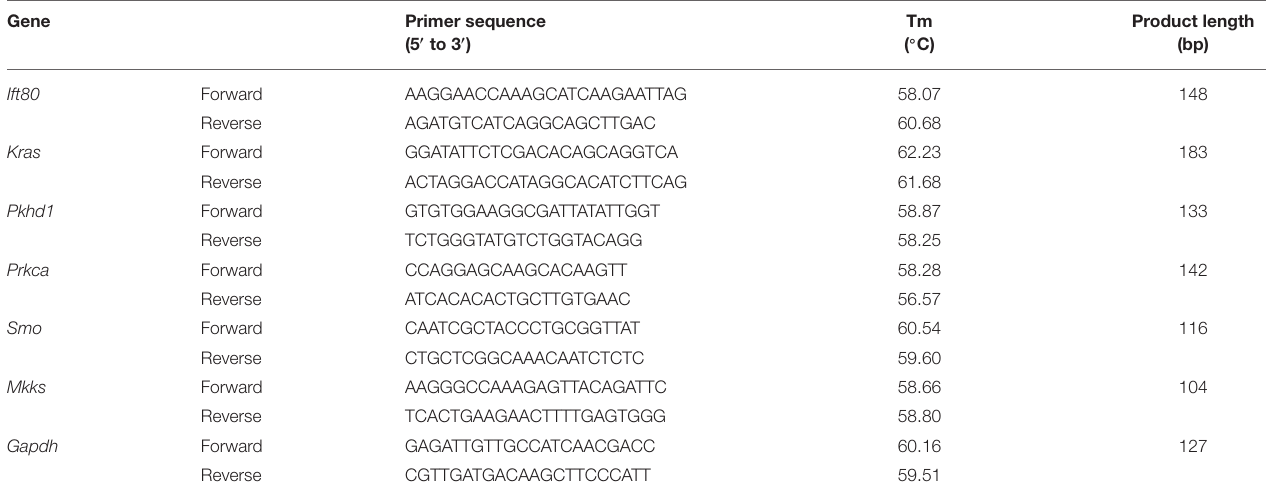
TABLE 1 | Primers used for the expression analysis of the cilia-related genes.